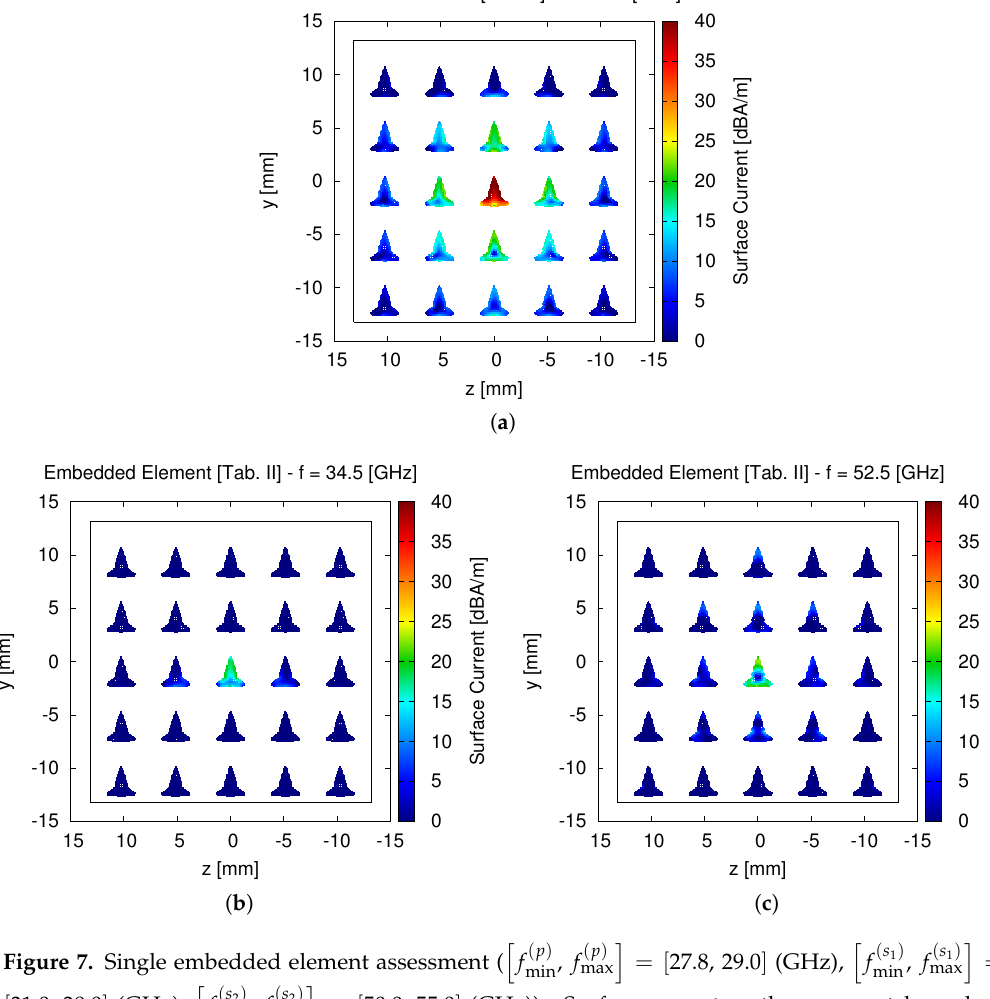
(cid:104) (cid:105) ( s 2 ) ( s 2 ) = [ 50.0, 55.0 ] (GHz))—Surface current on the array patches when f , f max min